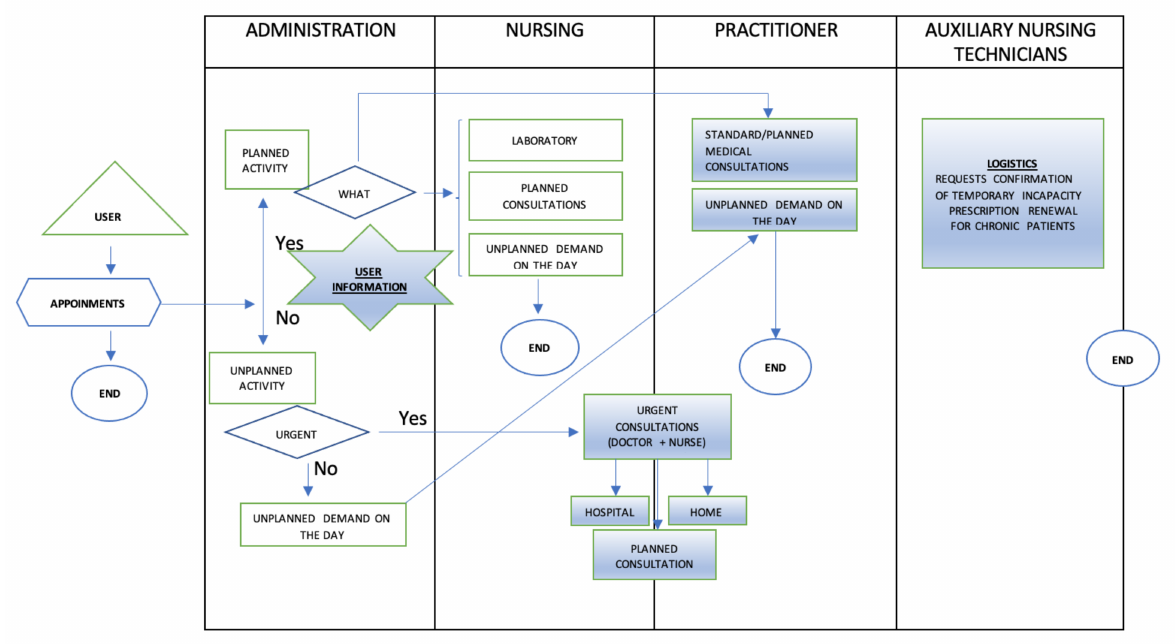
Figure 7. To-Be process diagram.